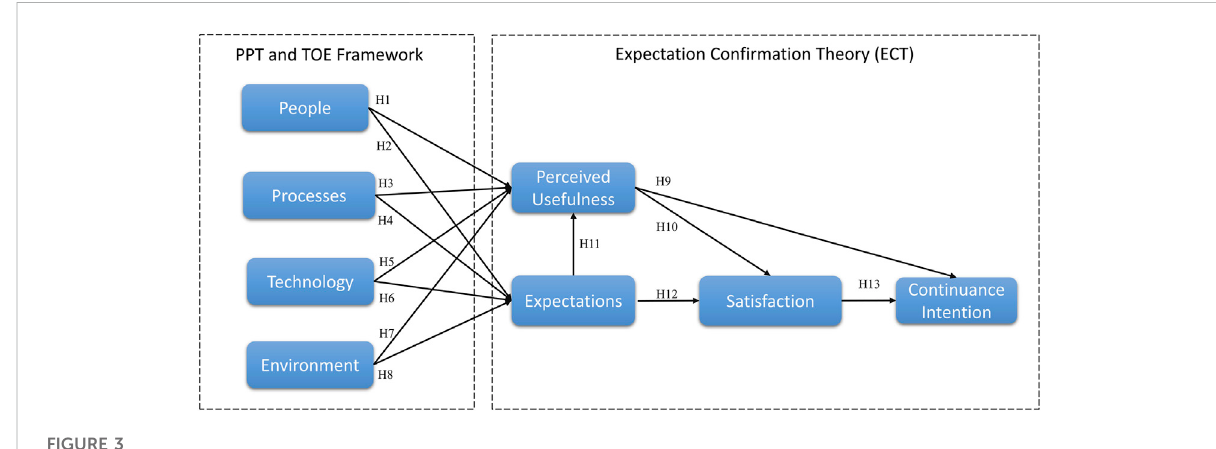
FIGURE 3 The Quantitative research